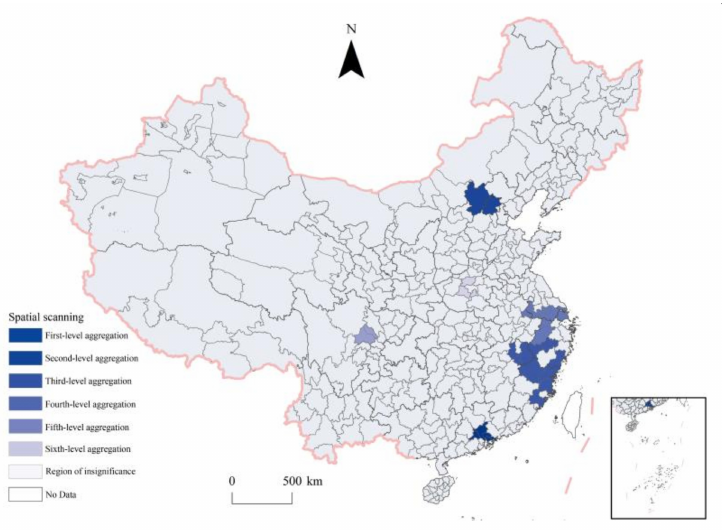
Figure 6. Cluster distribution of urban vitality index based on Flexible spatial scan